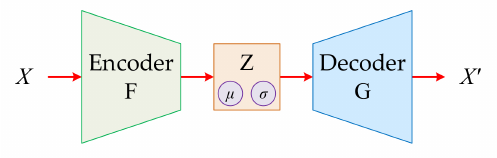
Figure 6. Basic structure of